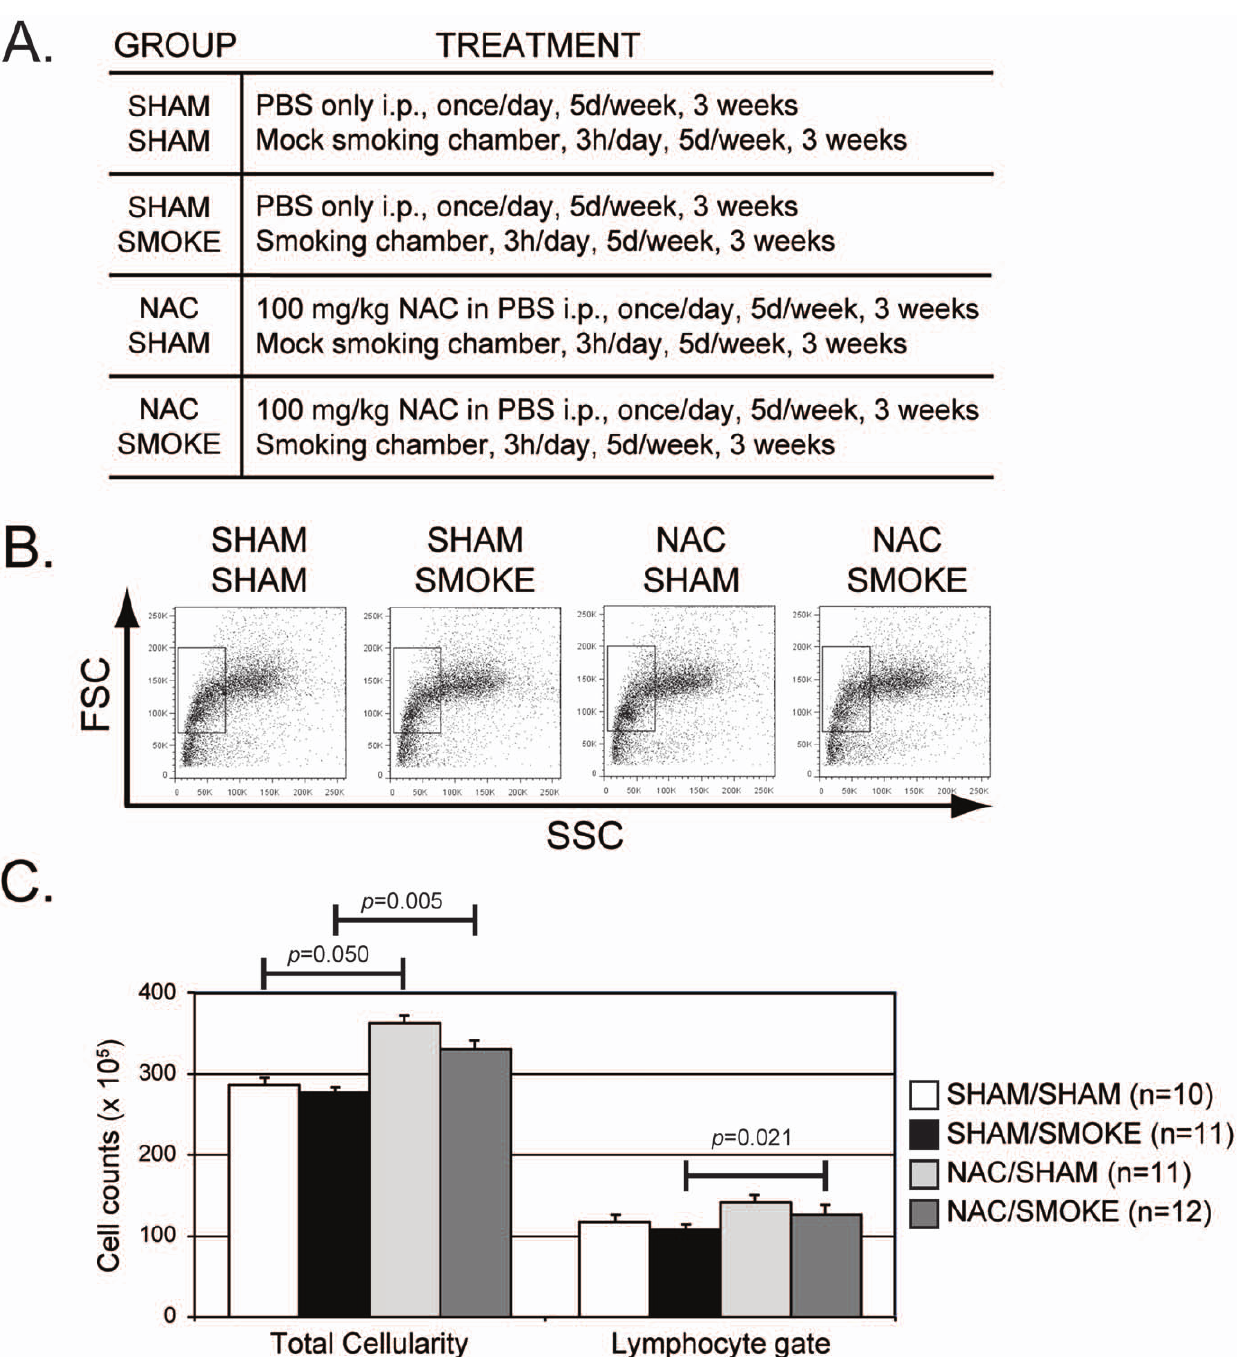
Figure 1. Total bone marrow and lymphocyte cellularities are increased by NAC treatment, but not smoke exposure. (A) Animals were divided into four groups and subjected to the treatments indicated. For additional details on experimental dosing, see Materials and Methods. (B) Bone marrow cells were analyzed by flow cytometry and a population with low forward scatter (FSC) and side scatter (SSC) properties enriched for viable lymphocytes was gated (Lymph + gate). A representative plot is shown for an animal in each treatment group. (C) Mean values for the total bone marrow and gated lymphocyte cell counts were calculated for each of the experimental groups. Statistically significant differences ( p , 0.05) are indicated.